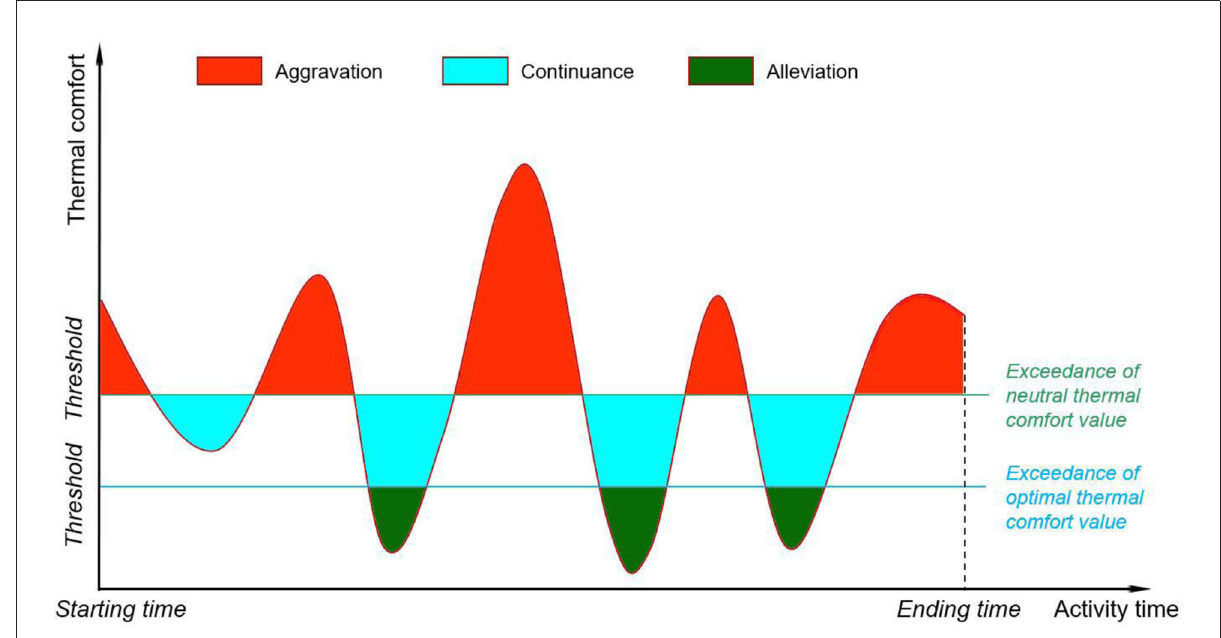
FIGURE2 Heat stress aggravation, continuance, and alleviation with activity duration.